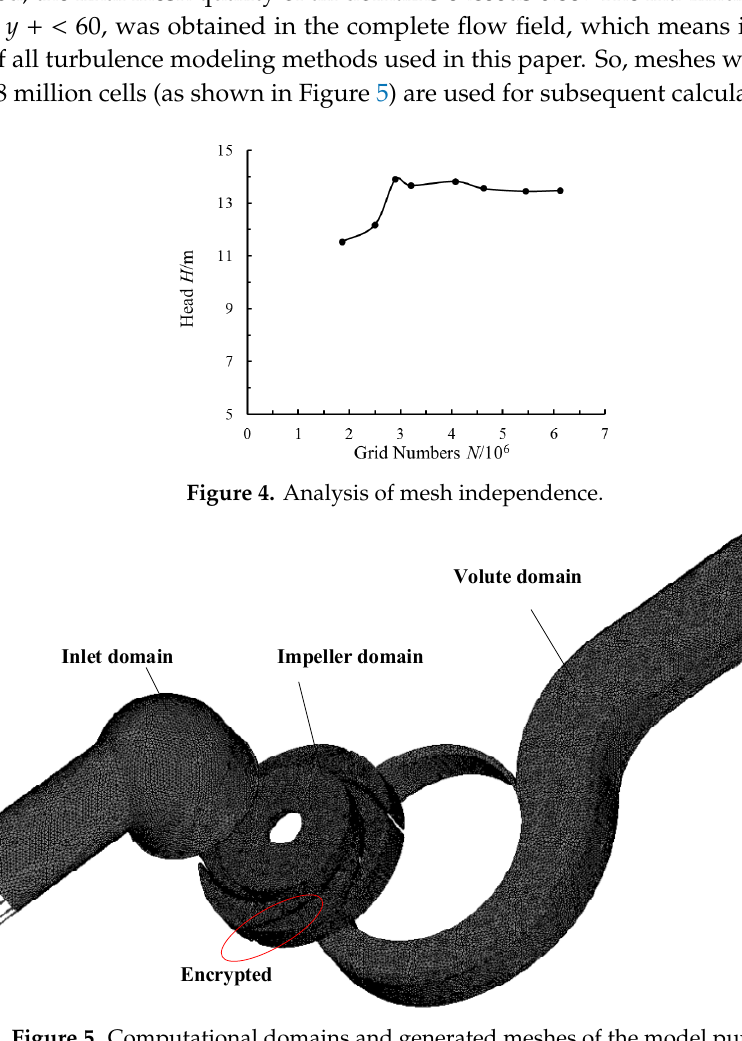
Figure 5. Computational domains and generated meshes of the model pump.